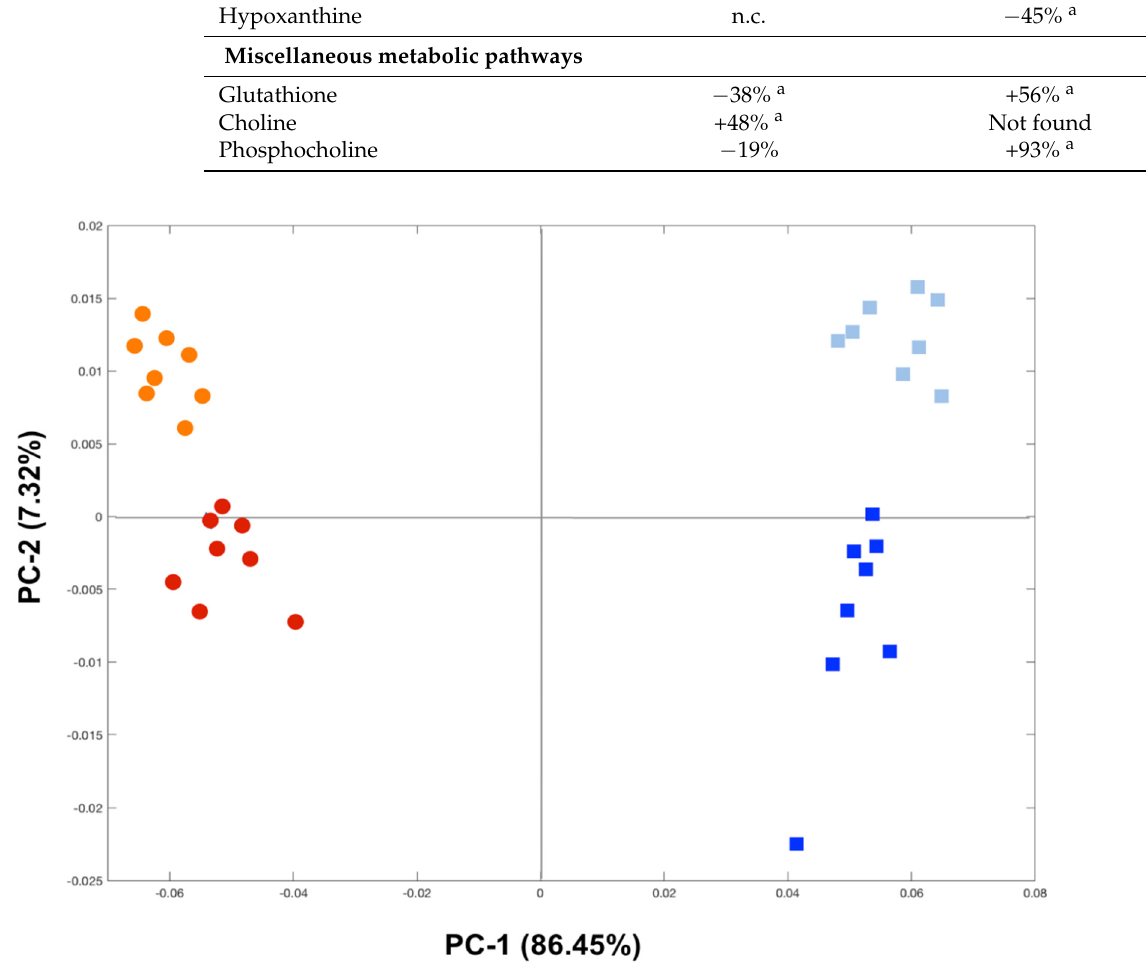
Figure 4. Principal component analysis (PCA) of 1 H NMR spectra of golden grey mullet gills (circles) and liver (squares) showing separation (PC-1 vs. PC-2) between the fish that were collected at SJ (orange circles and light blue squares) and those from LAR (red circles and blue squares). Table 3. The relative changes in metabolite concentrations between LAR and SJ golden grey mullets ( p < 0.05 a ; Student’s t test) in both the gills and liver (+ and − indicate metabolite increase and de- crease, respectively, in the organs of fish from LAR with respect to those from SJ; “n.c.” indicates no changes that were induced by Hg exposure).